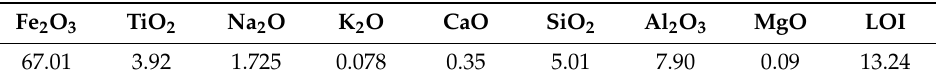
Table 1. Chemical composition of the red mud (mass%).